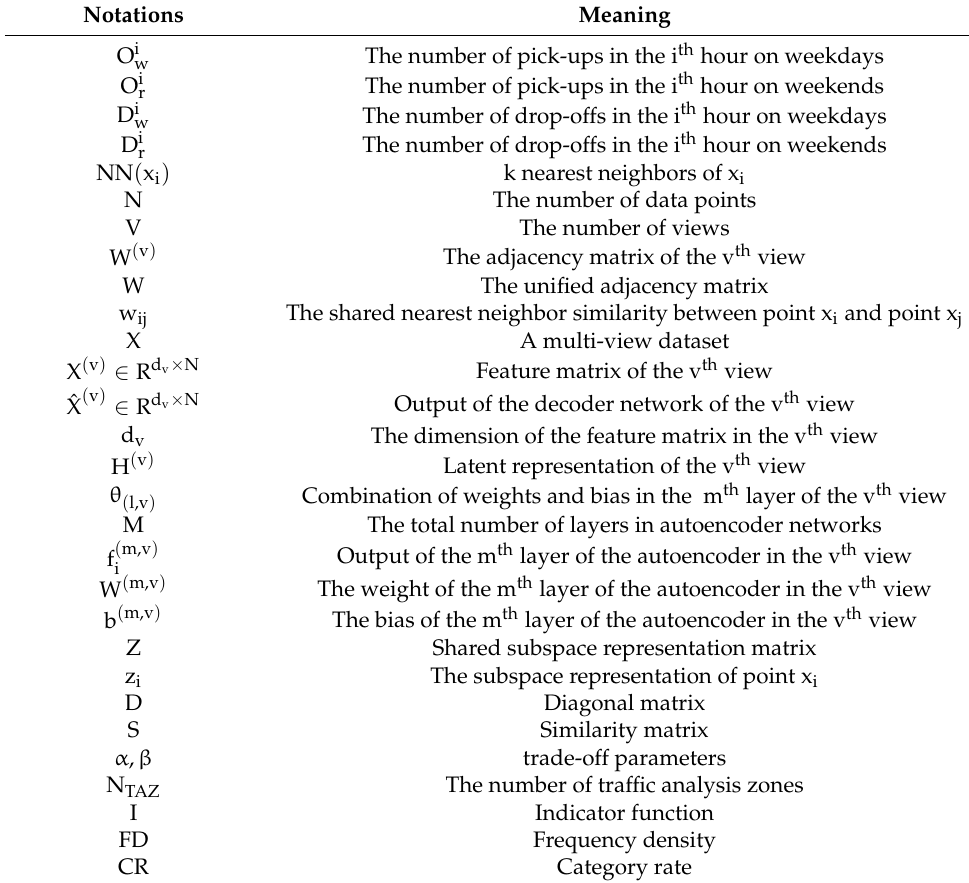
Table 1. Main notations and meanings through this